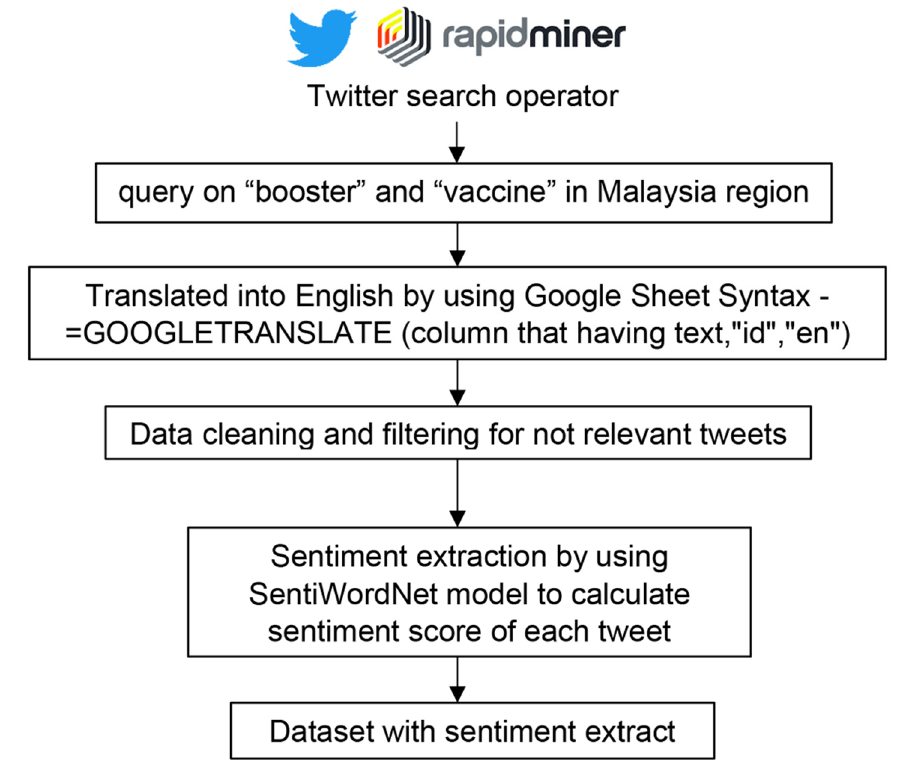
Figure 1. Process flow of dataset construction.